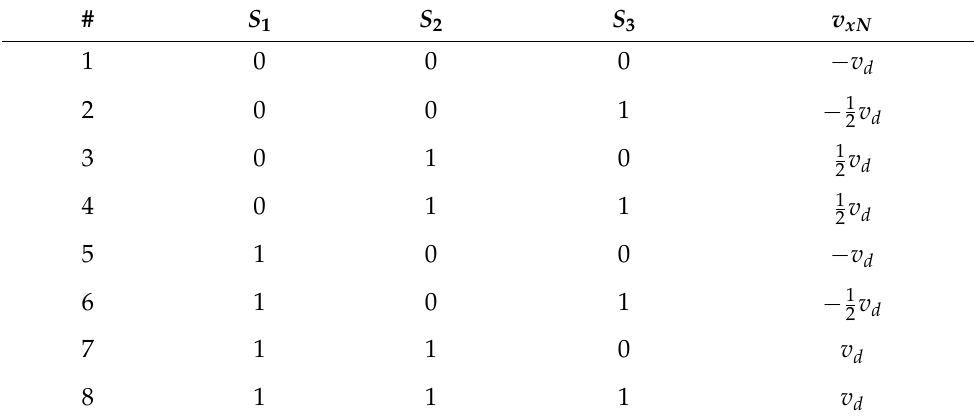
Table 1. Allowed switching states and output voltages for the proposed four-level